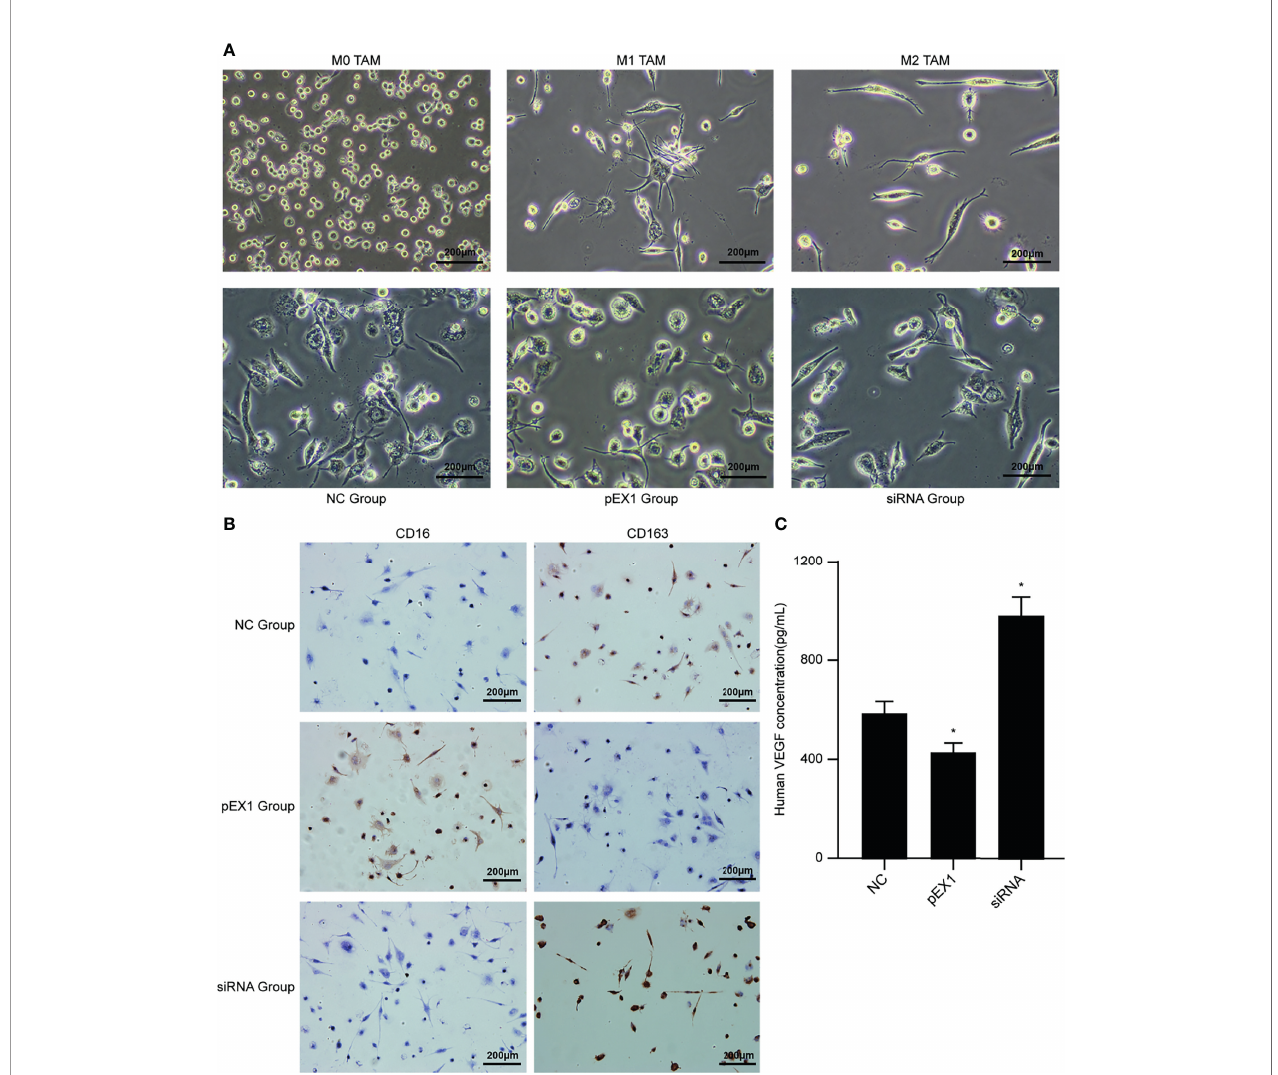
FIGURE 4 | Conditioned medium induced polarization of M1 TAMs. (A) Microscopic observation of M0/M1/M2 TAMs and induced macrophages in each group (100×); (B) Immunocytochemical method for phenotypic identi fi cation of macrophages in each group (100×); (C) VEGF content in the supernatant of macrophages in each group. (siRNA group: S2 sequence). * p < 0.05 compared to the NC